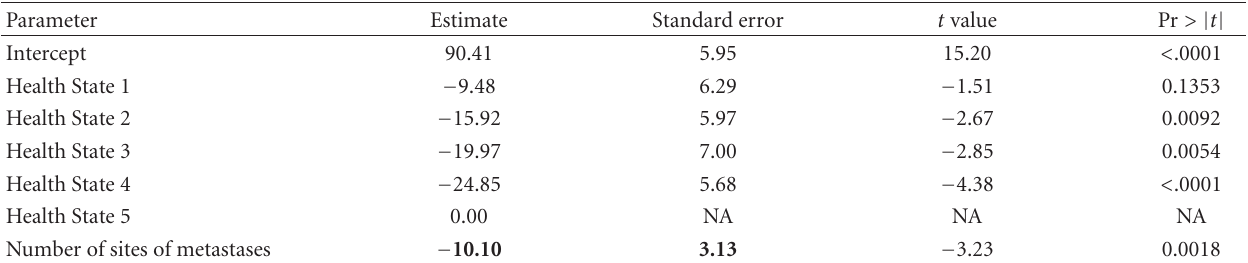
Table 7: Multiple linear regression analysis, with health-related quality of life as dependent